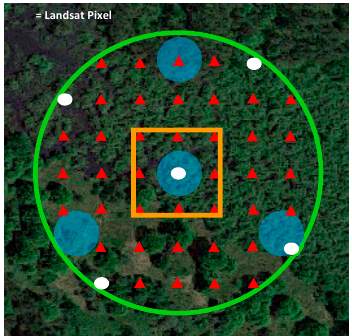
Figure 3. The spatial scale of plot data collected under the three different observation systems. FIA plots involve field data collection within four subplots, depicted by light blue circles. Image-based Change Estimation plots make observations on a sample of dots within a 0.61 hectare circle (light green) surrounding the FIA subplots. For areas with no change from one time period to the next, data are collected only on the five white dots. For plots where change is present, data are collected on all 45 dots (white dots and red triangles combined). Finally, for TimeSync, observations are made for the 30-m pixel intersecting the center FIA subplot, depicted by an orange box.